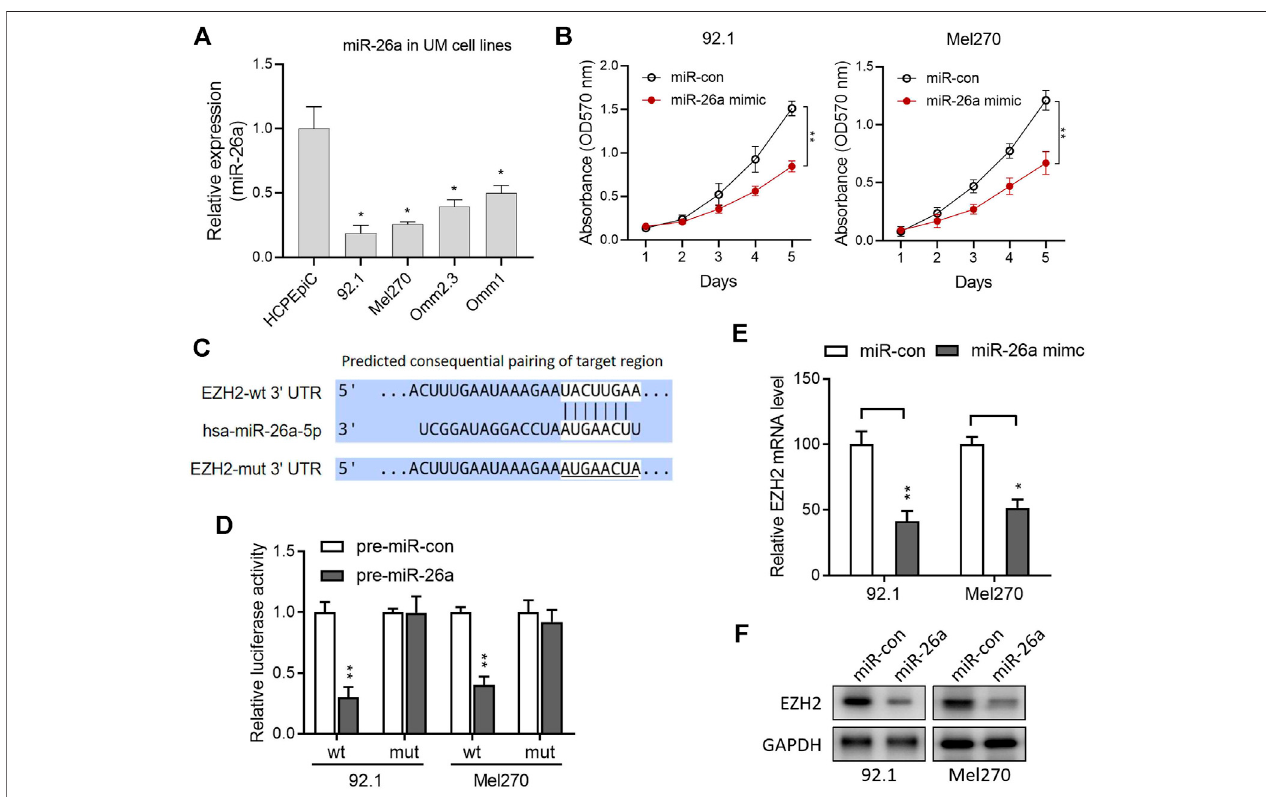
FIGURE 2 | EZH2 was identi fi ed as a target of miR-26a in UM. (A) Relative levels of miR-26a expression in the UM cells. * p < 0.05 vs. HCPEpiC. (B) The effect of ectopicmiR-26aexpressiononcellproliferationinthe92.1andMel270cellswasevaluatedbytheMTTassay. (C) The3 ′ -UTRoftheEZH2mRNAincludedthepredicted bindingdomainofmiR-26a. (D) The92.1andMel270cellsweretransfectedwithpre-miR-conorpre-miR-26a,andthereportervectorswiththefull-lengthwild-type(wt) or mutant (mut) EZH2 3 ′ -UTR; luciferase activity was detected. (E) qRT-PCR was used to evaluate the EZH2 mRNA levels in 92.1 and Mel270 cells with ectopic miR-26aexpression(* p < 0.05,** p < 0.01vs.miR-con). (F) TheeffectsofectopicmiR-26aexpressionontheEZH2proteinlevelsof92.1andMel270cellsweredetected by western blotting. Abbreviations: UM, uveal melanoma; EZH2, enhancer of zeste homolog 2; HCPEpiC, human choroid plexus epithelial